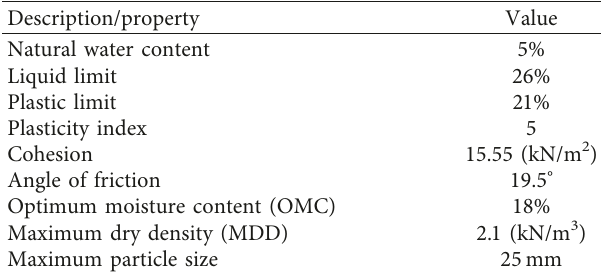
Figure 3: (a) A detailed sketch and (b) a photo of cyclic triaxial apparatus. Table 1: Essential physical parameters of